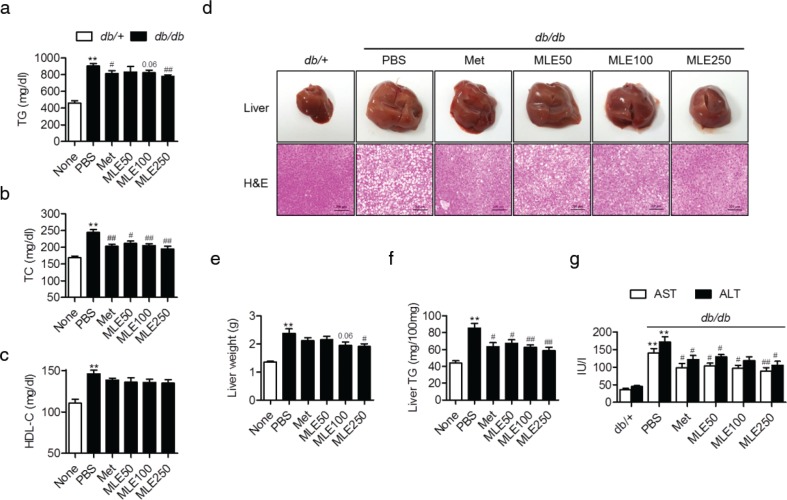
Effects of MLE supplementation on hepatic steatosis and serum lipid profiles in db/db mice. (a–c) At the end of the study, serum levels of triglyceride (TG), total cholesterol (TC), and high-density lipoprotein cholesterol (HDL-C) were analyzed. (d) Macroscopic and microscopic images of liver sections. Liver sections were stained with H&E. Bar = 100 μm. (e, f) Liver wet weight and hepatic TG content were determined. (g) Serum levels of AST and ALT were measured as an index of liver injury. Values are expressed as mean±SEM (n = 7/each group). **p < 0.01 versus db/+, #p < 0.05 and ##p < 0.01 versus db/db+PBS.